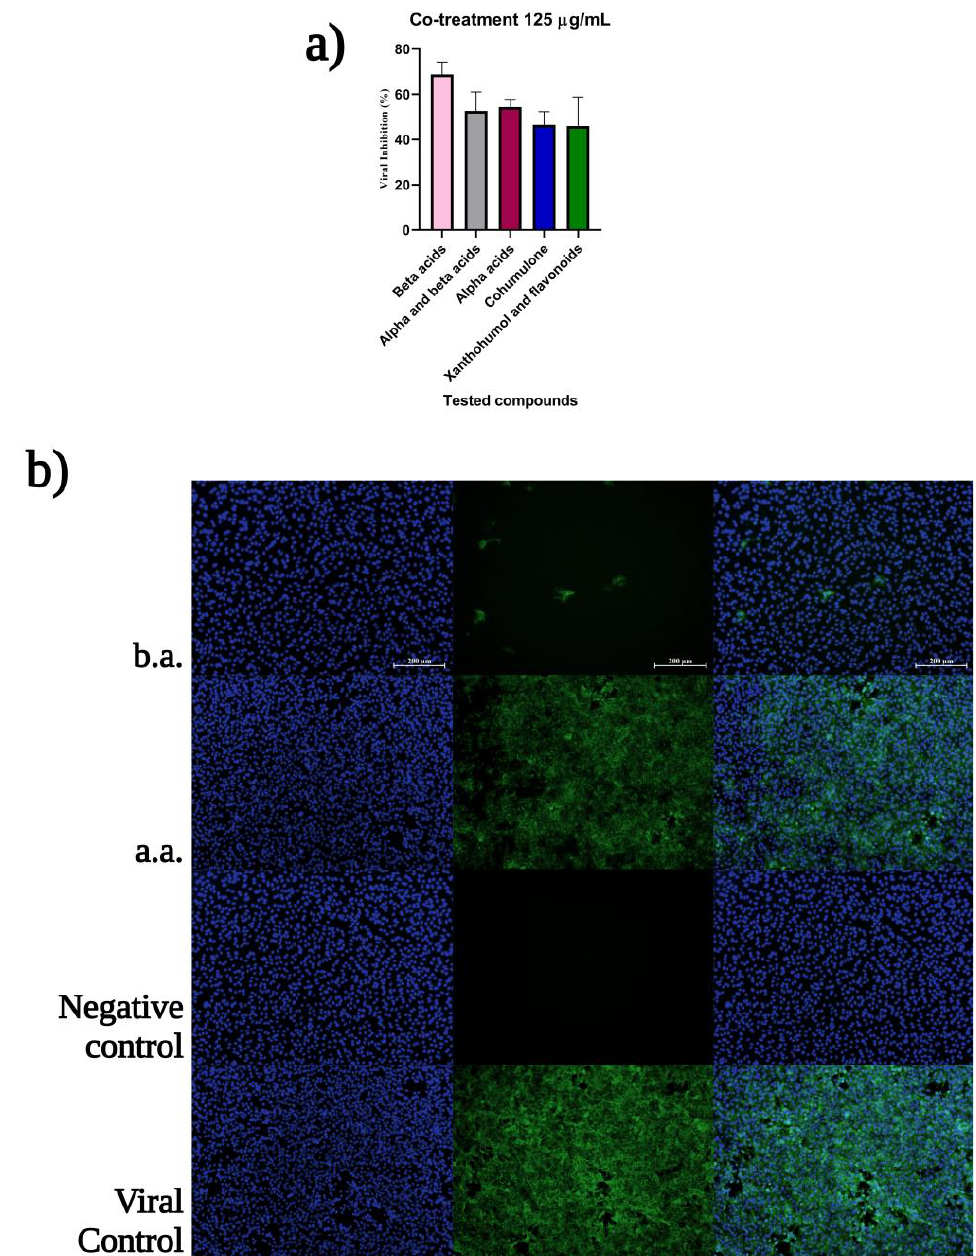
Figure 6. ( a ) β -acids has virucidal activity and blocks CHIKV entry to the host cells during the co-treatment assay; ( b ) The immunofluorescence assay in 125 µ g/mL at MOI 0.1, shows significant difference between inhibition of the entry stages by β -acids (b.a.) and α -acids (a.a.) where the growth lag is closer to the viral control. Images are representative of three independent experiments. Scale bars are 200 µm. Visual sensitivity was increased to shallow contrast by Adobe Photoshop 2021.